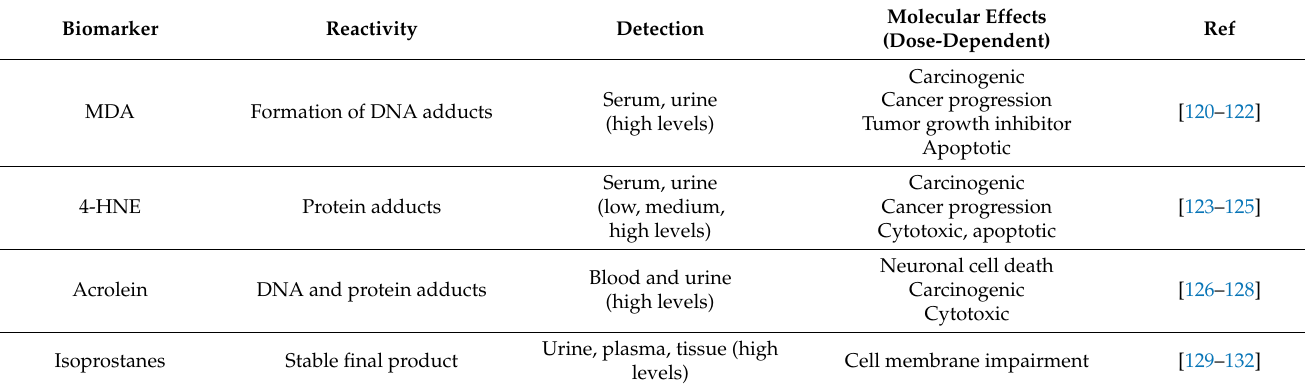
Table 4. Lipid peroxidation biomarkers and main reactivity with biomolecules, together with detec- tion and molecular effects in